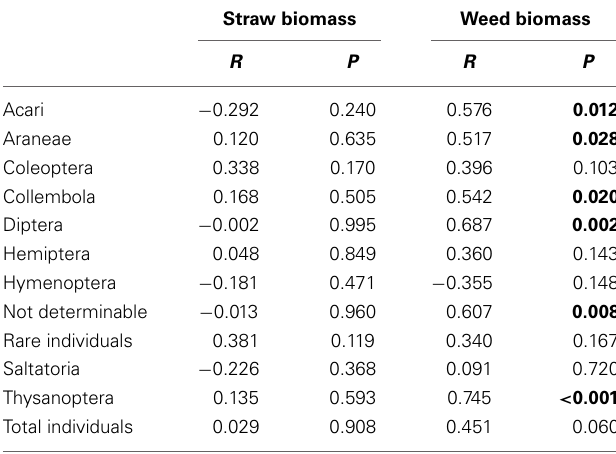
Table 5 | Correlation between arthropod abundance (June sampling) and straw and weed biomass (Pearson’s product-moment